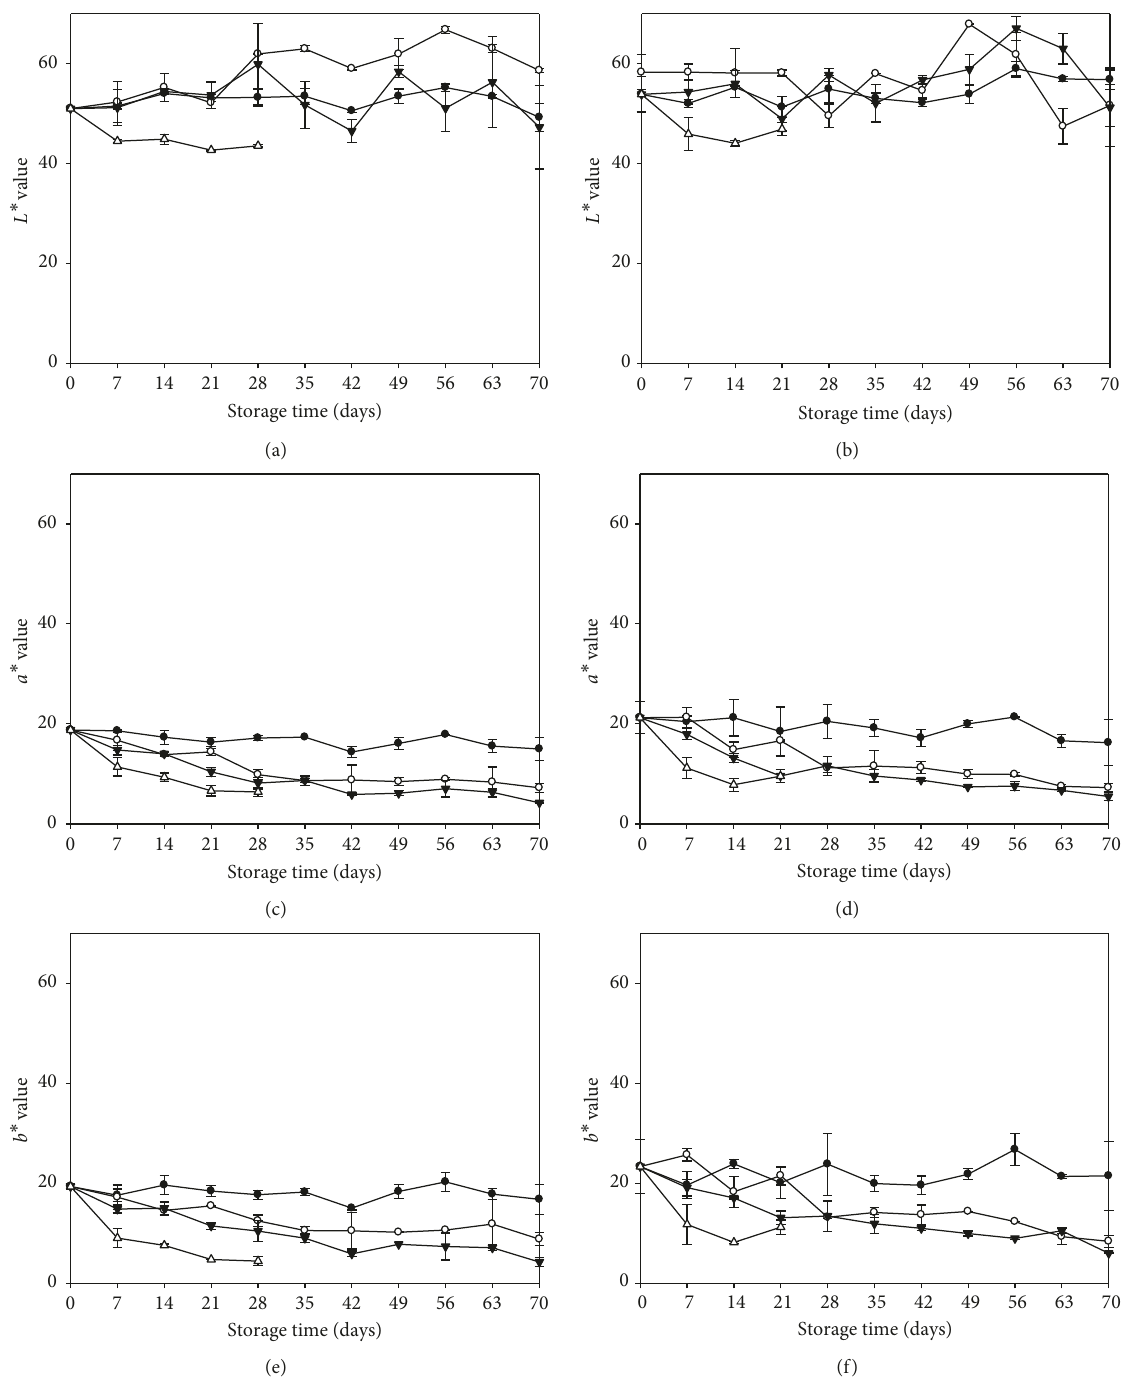
Figure 1: Change of color ( L ∗ , a ∗ , and b ∗ values) in dried persimmon-1 and dried persimmon-2 during storage at different temperatures ( − 20, 5, 12, and 25 ° C) for 70 days. Dried persimmon-1 (a, c, e) and dried persimmon-2 (b, d, f). L ∗ value (a, b), a ∗ value (c, d), and b ∗